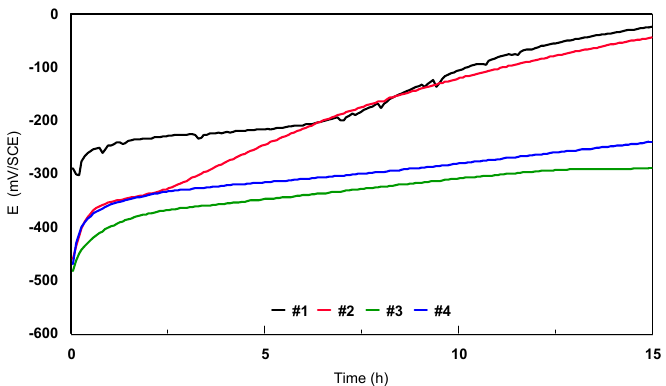
Figure 13. Open circuit potential vs. immersion time curves for bulk Ti-based alloys in 9 g / L NaCl electrolyte. SCE: saturated calomel electrode.